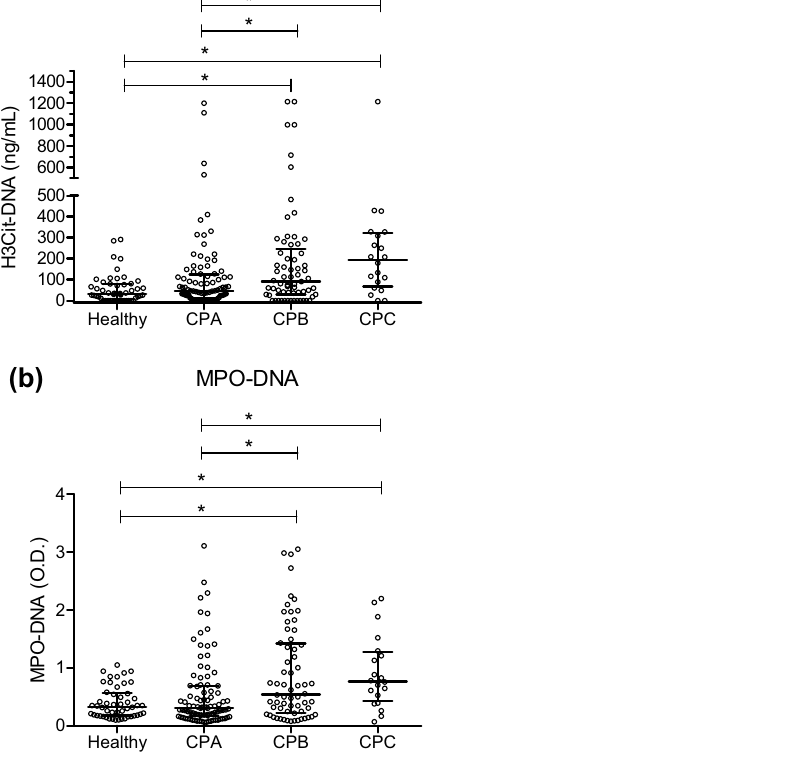
Figure 2. Plasma levels of H3Cit-DNA and MPO-DNA in healthy controls and patients with different Child– Pugh Scores. The cirrhosis and HCC groups are pooled together. ( a ) Child–Pugh B (CPB) and Child–Pugh C (CPC) patients had significantly elevated H3Cit-DNA levels as compared to healthy controls and Child–Pugh A (CPA). The difference between Child–Pugh B and Child–Pugh C was not significant. ( b ) Child–Pugh B